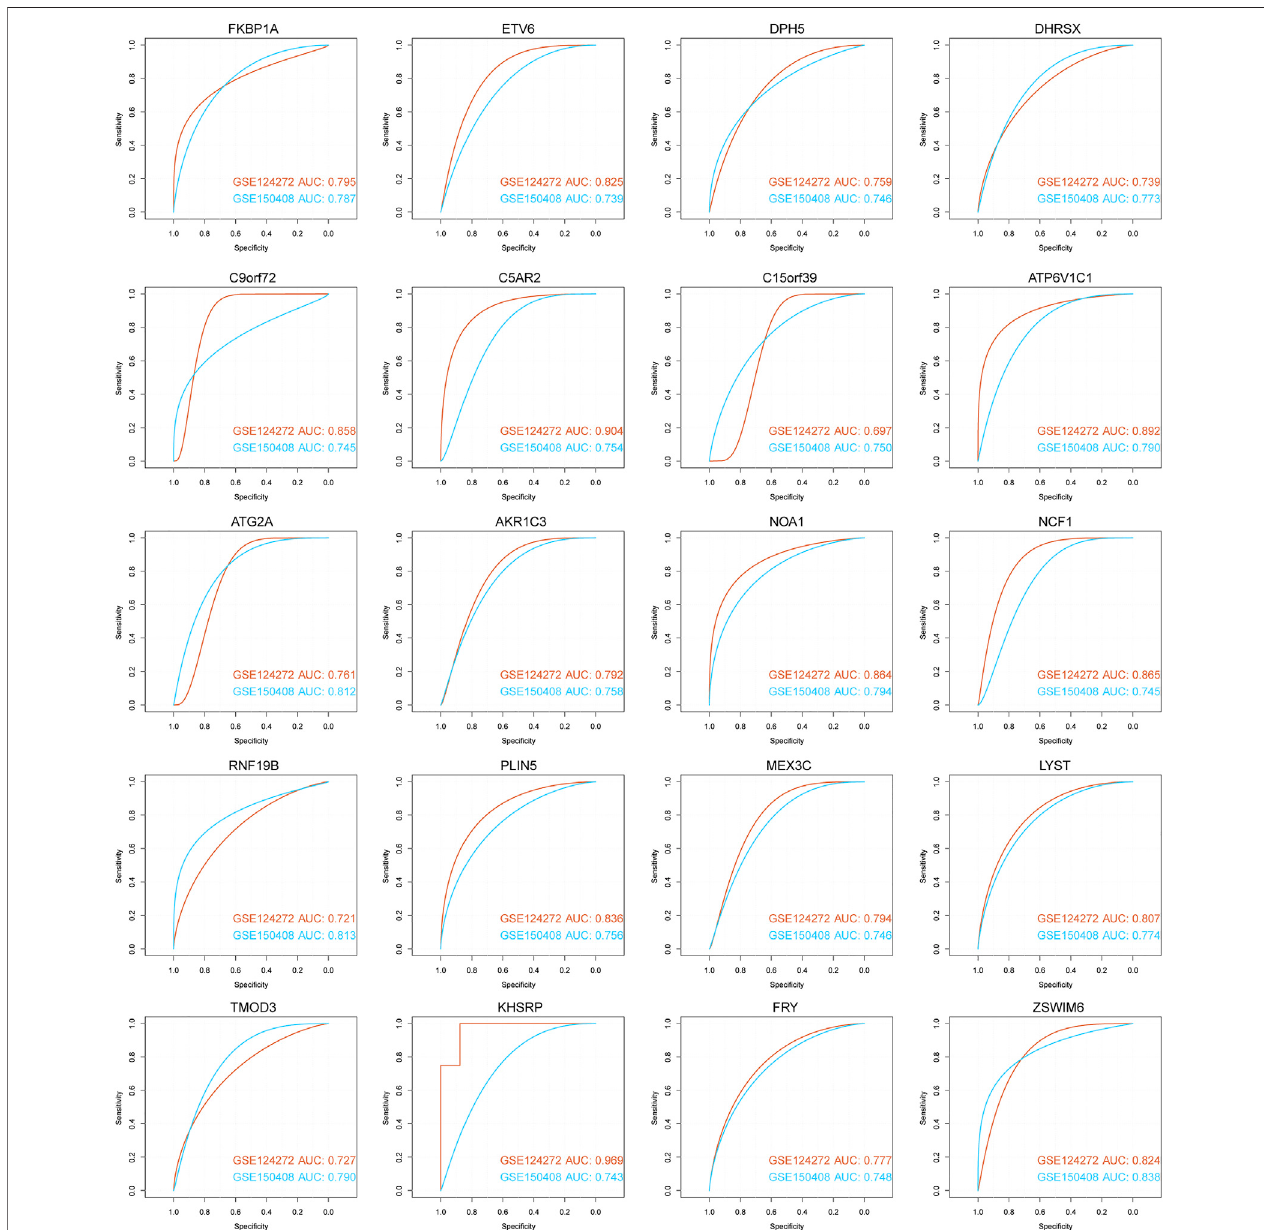
FIGURE9| ROCcurve fordiagnosisof20hubgenes.Thehorizontal axisrepresentsthetest ’ sspeci fi city,andtheverticalaxis represents thetest ’ ssensitivity.The brick red curve is the test result for data 1, and the blue curve is the test result for data 2.